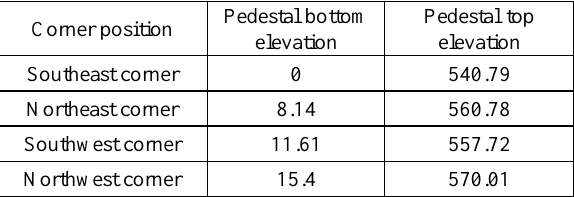
Table 1. The elevation at each corner of the pedestal (unit: mm) As can be seen from table 1, among the four corners of the pedestal, the elevation at the southeast corner is the lowest, and